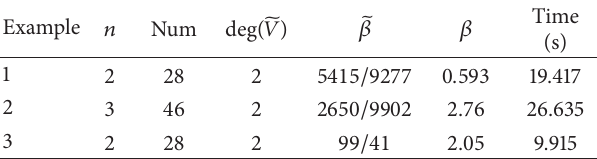
Table 2: Algorithm performance on benchmarks